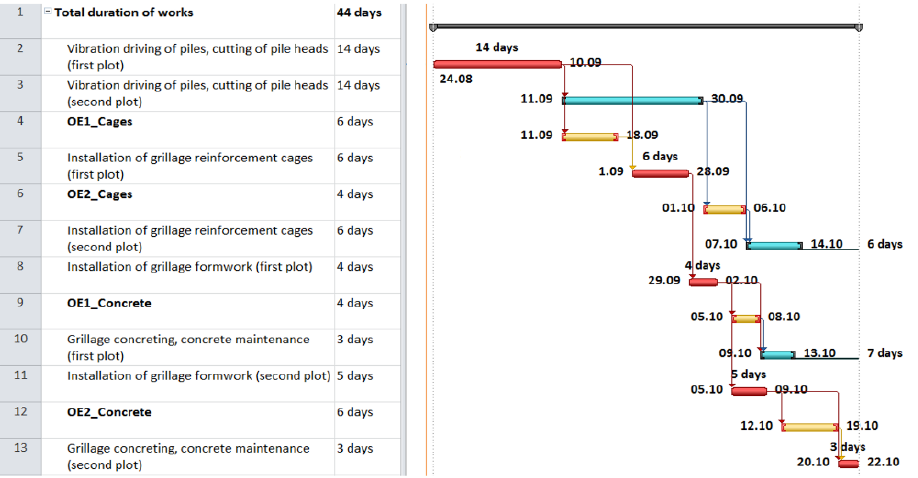
Figure 6. A 44-day s’ schedule option. Figure 6. A 44-days’ schedule option. Table 1. Optimal